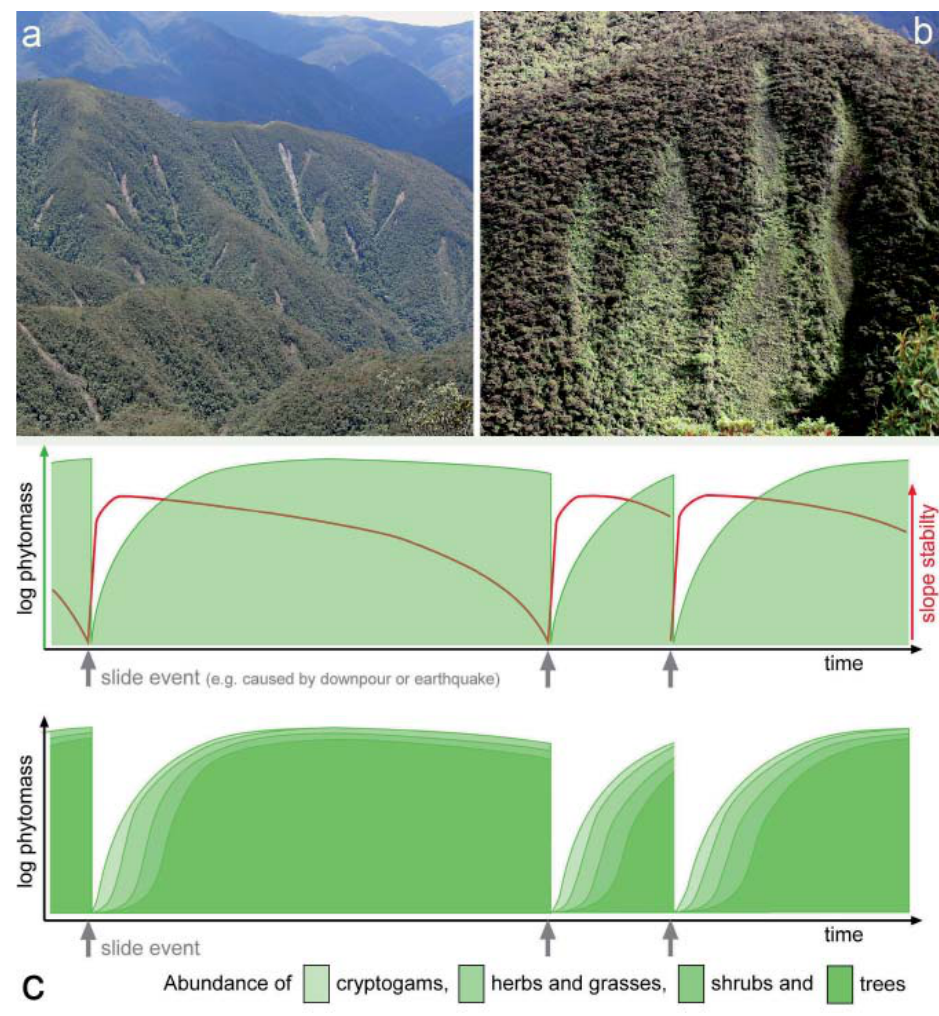
Figure 16: Landsliding as triggers of a dynamic mosaic of plant cover regeneration stages in the mountain rainforest. Active sliding zone between 2,300 and 2,600 m a.s.l. on the RBSF-terrain (a) and plant recovery 20-40 years after slide processes near the research area at around 2,300 m a.s.l. (b). The upper sketch in (c) indicates the relationship between total plant biomass (green field) and slope stability (red line); biomass inc- rease causes weight increment and leads to slope instability (sketch design partly by Elsenbeer, pers. comm.). Arrows indicate landslide events. The lower sketch illustrates non-linear trajectories describing changes in the abundance of different functional groups of plants through time (area under each curve). The time scale is in the order of few centuries. (photos: M.